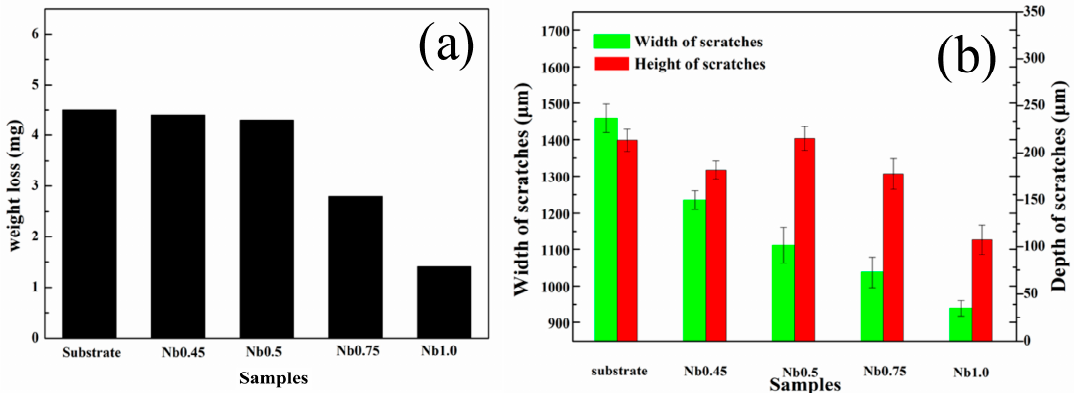
Figure 5. ( a ) Wear mass loss of all samples. ( b ) Depth and width of wear scars of the samples.